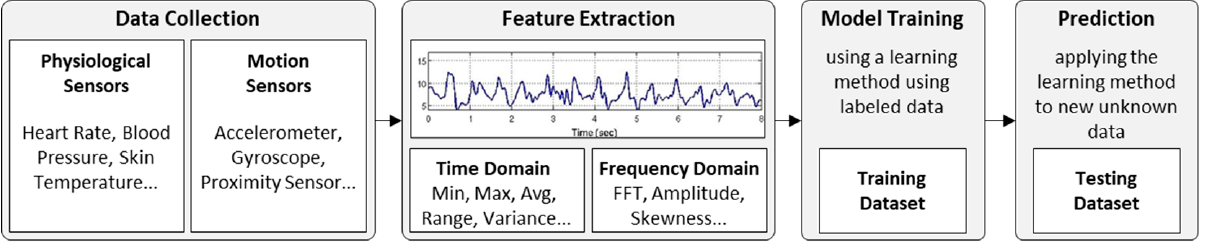
Figure 1. General data-processing flow for HAR.